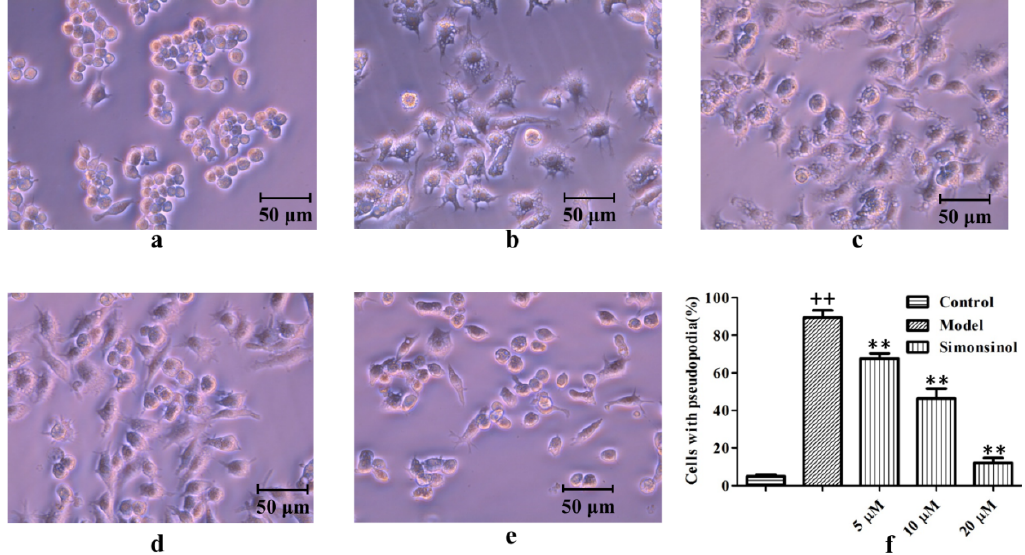
Figure 3. Effect of simonsinol on LPS-stimulated RAW264.7 cells morphology. ( a ) Blank control RAW264.7 cells. ( b ) Model RAW264.7 cells stimulated by LPS for 24 h. ( c – e ) RAW264.7 cell treated